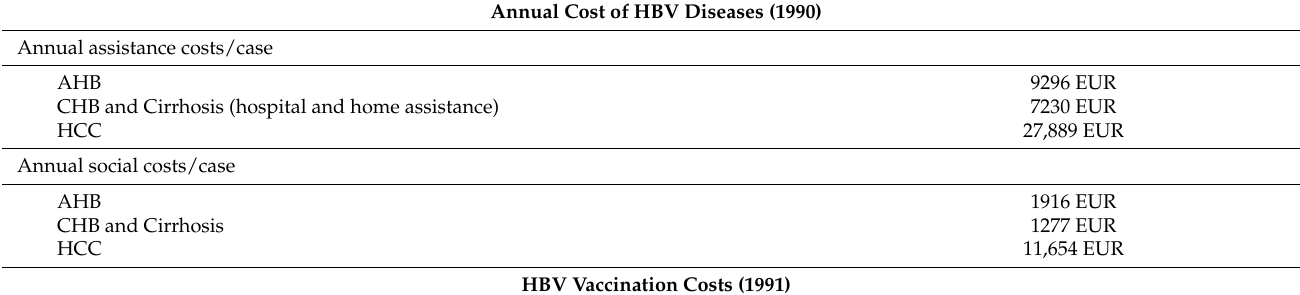
Table 2. Annual clinical costs of HBV diseases (referring to 1990) and hepatitis-B-vaccination costs (referring to 1991) for Acute Hepatitis B (AHB), Chronic Hepatitis B (CHB), Compensated Cirrhosis (CC) and Hepatocellular Carcinoma